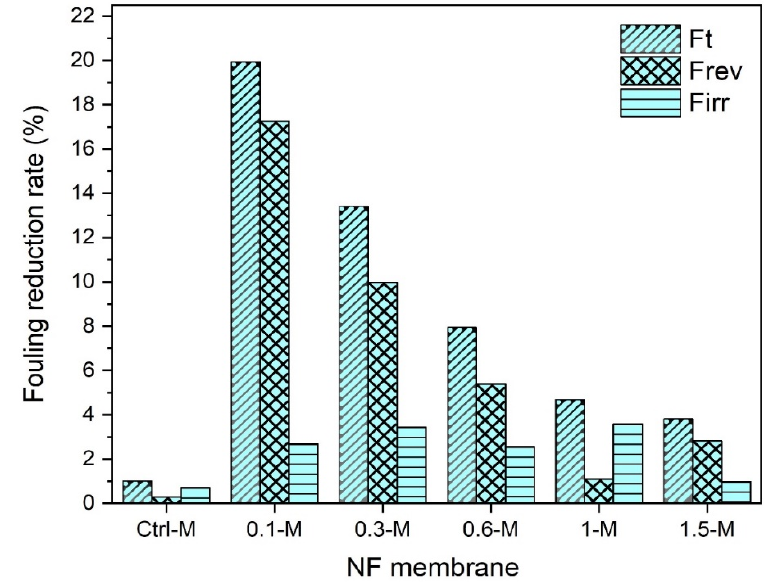
Figure 12. Fouling behavior of NF membranes with 50-ppm copper solution.